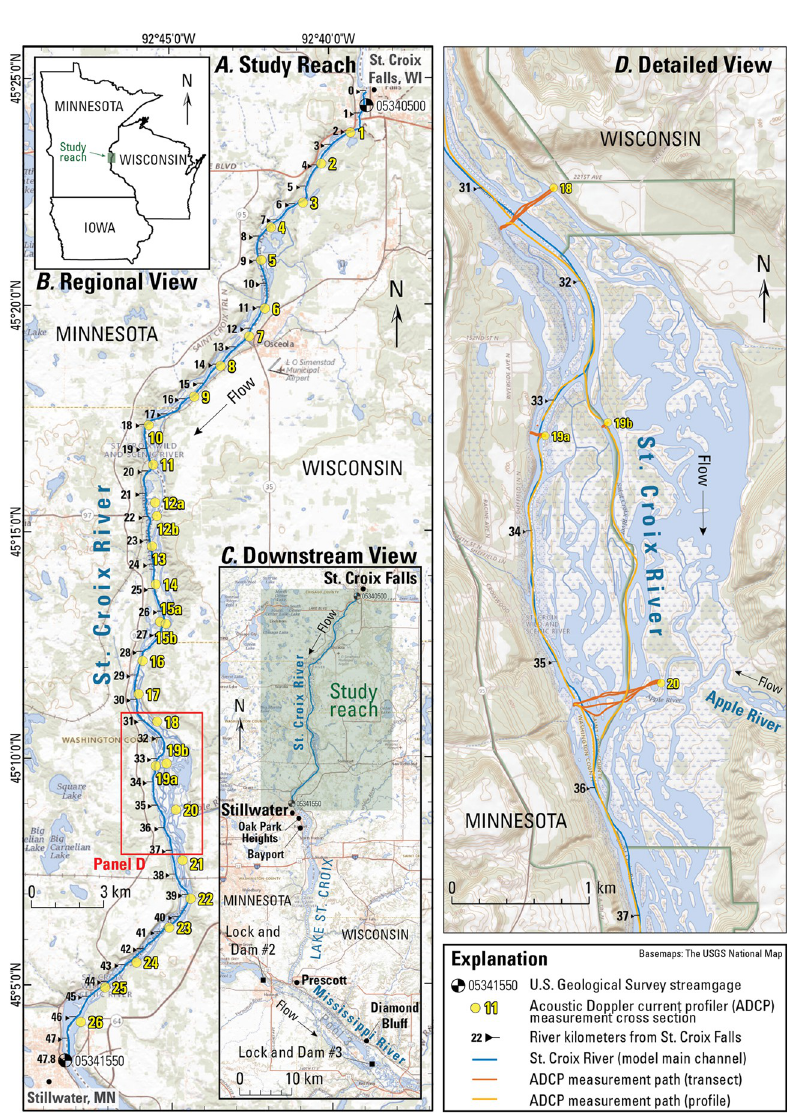
Fig 1. Study area overview map of the 47.8-kilometer St. Croix River study reach between St. Croix Falls, Wisconsin, and Stillwater, Minnesota. (A) acoustic Doppler current profiler (ADCP) data collected during June 19– 22, 2018, where yellow dots show locations of transect stations; (B) regional overview inset map; (C) downstream map showing the study reach in the context of the lower St. Croix River to its confluence with the Mississippi River; (D) detailed inset image depicting ADCP data collection in a multi-thread segment of the study